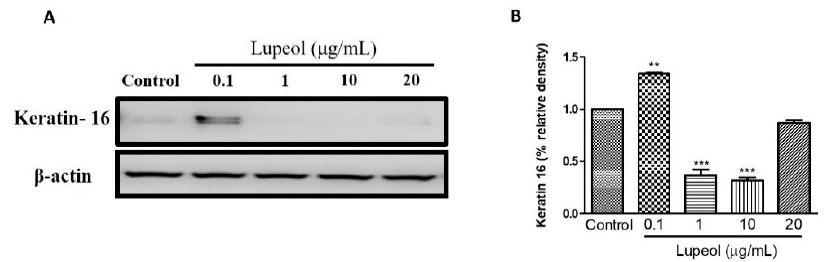
Figure 9. Lupeol regulates the expression of keratin 16 in epidermal keratinocytes. ( A ) Western blot showing expression of keratin 16 in keratinocytes after 24-h treatment with lupeol. ( B ) All the proteins were semi-quantitated using ImageJ software and normalized to the levels of β -actin. Data are expressed as mean ± SEM. ** p < 0.01 and *** p < 0.001 versus control group.